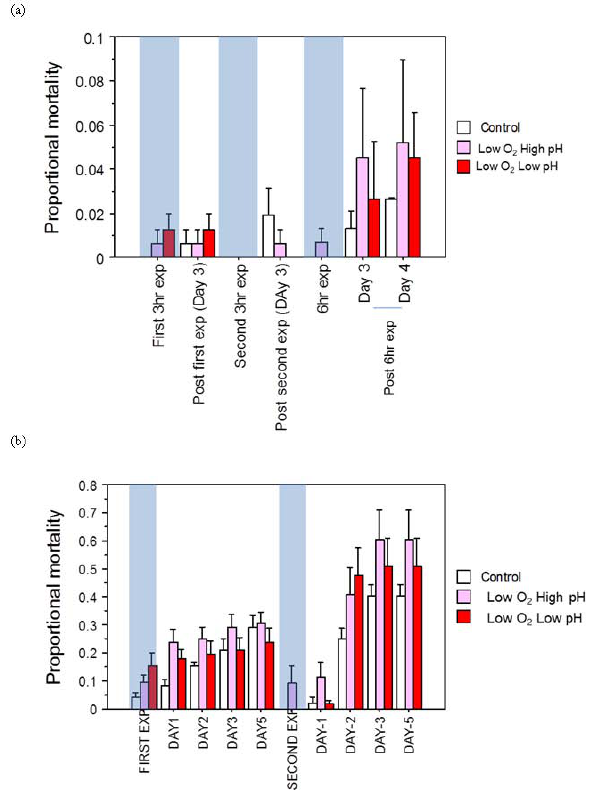
Fig. 2. Haliotis rufescens : cumulative mortality (mean ± s.e.) of ju- veniles abalone after each exposure to control, upwelling, and low- oxygen treatments. (a) Experiment I. (b) Experiment II. Shaded days represent exposure of abalones to different treatments. The day number represents the days after the exposure treatment.